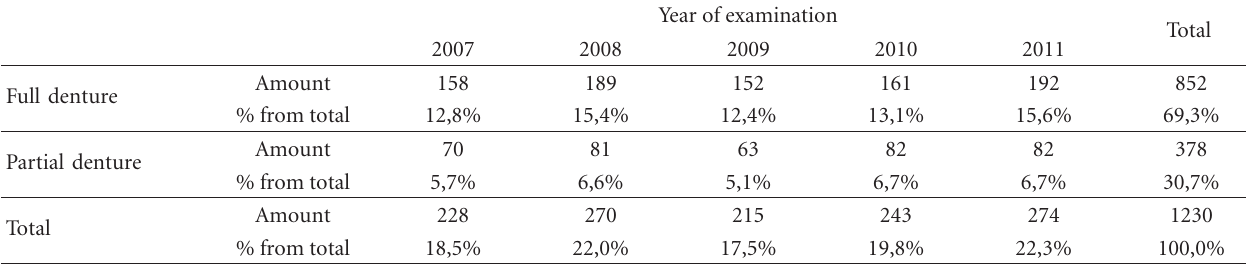
Table 5: Distributions of dentures according to the year of examination.